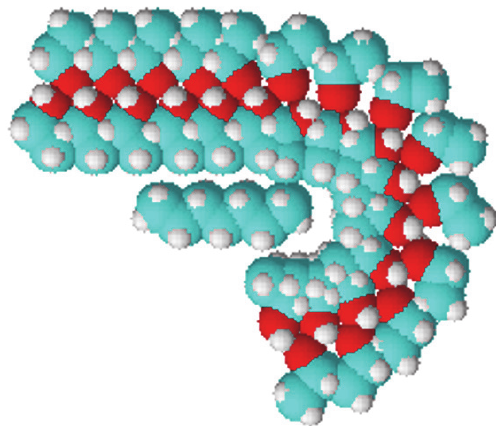
Figure 11: Molecular structure of anhydrous ethanol being added with 8% v of